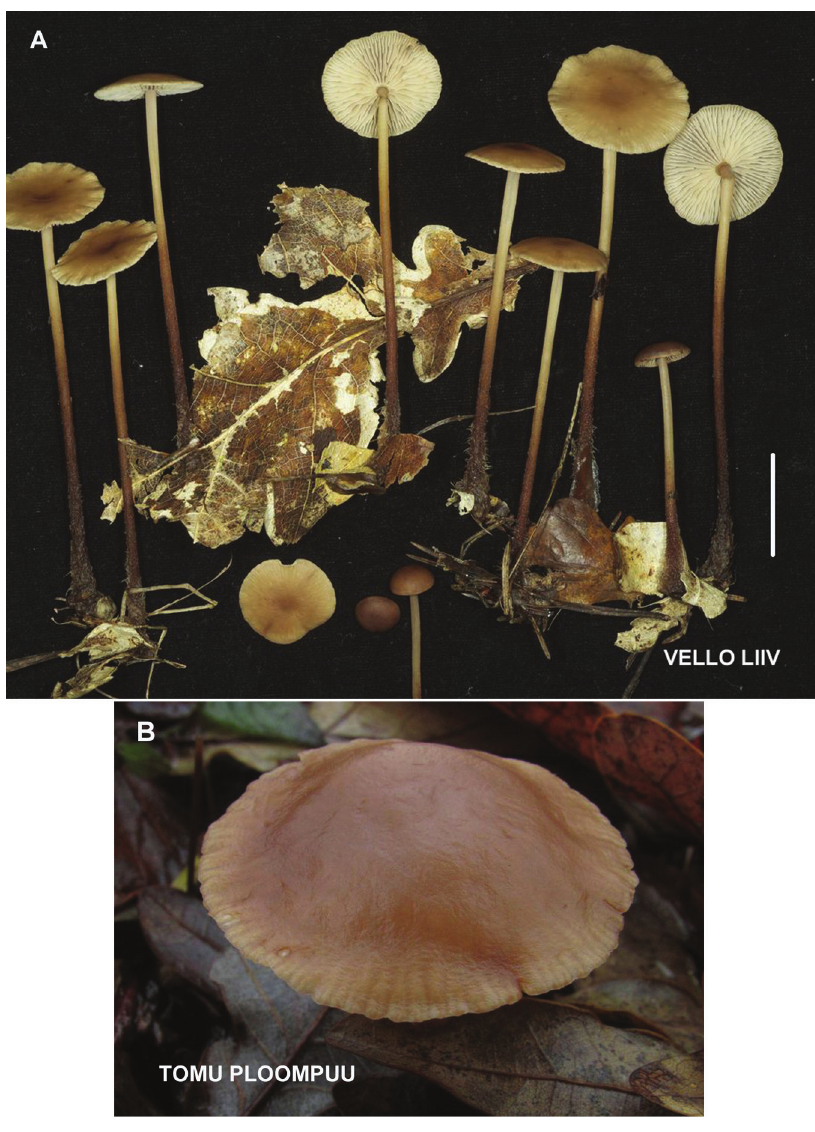
Figure 59. Mycetinis prasiosmus . Basidiomata. A TU 118971 B TU 101659. Standard bars: A = 20 µm; B not to scale. Photos courtesy Urmas